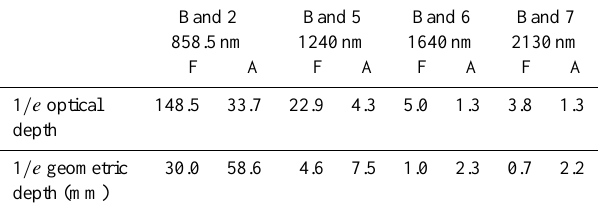
Table 3. E-folding depth for the MODIS bands used in this study for two extreme cases of snow: F – fresh light snow, r opt = 50µm, density=150kgm − 3 ; A – aged dense snow, r opt = 1000µm, den- sity = 350kgm − 3 . The values were calculated with DISORT and assuming spherical and disconnected snow